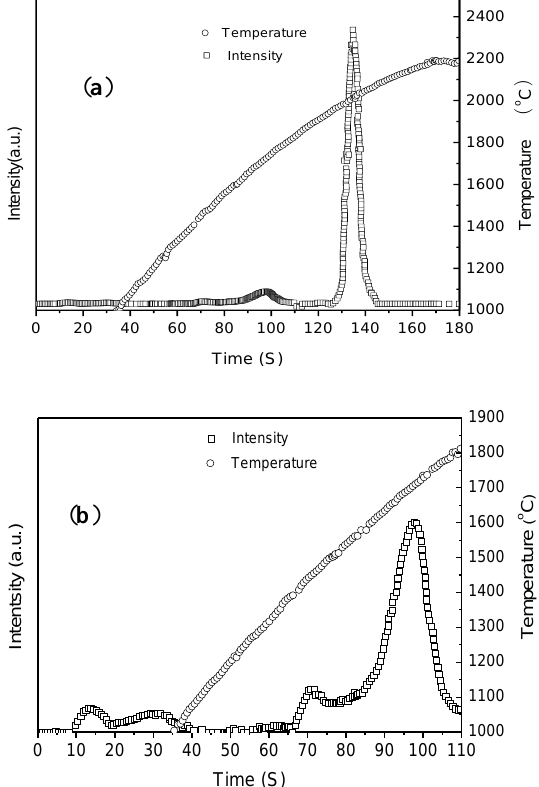
Figure 4. ( a ) Release curve of oxygen in the passivated nanopowders synthesized from the master alloy of Ti–48Al by HPMR in N 2 , H 2 , and Ar atmosphere; ( b ) the amplification in the time range of 0–110 s.